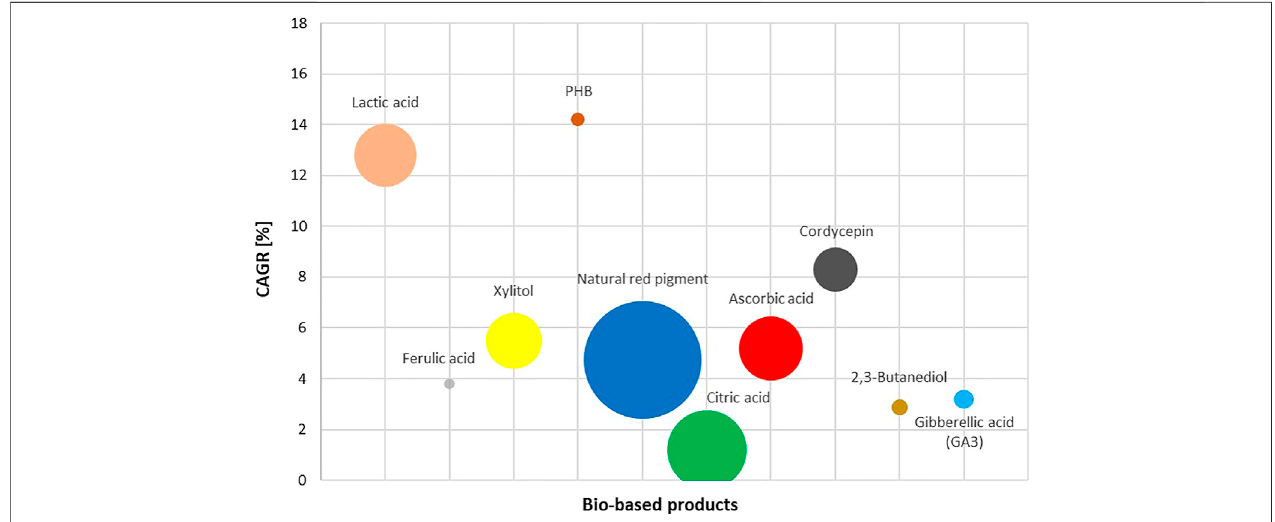
FIGURE 1 | Market size and related growth rate (CAGR) of selected value-added products from BSG hydrolisates (PHB, poly-3-hydroxybutyrate (as a part of the PHA group); Natural red pigment as a part of natural pigment group). The size of the bubble represents the relative market size in 2020.